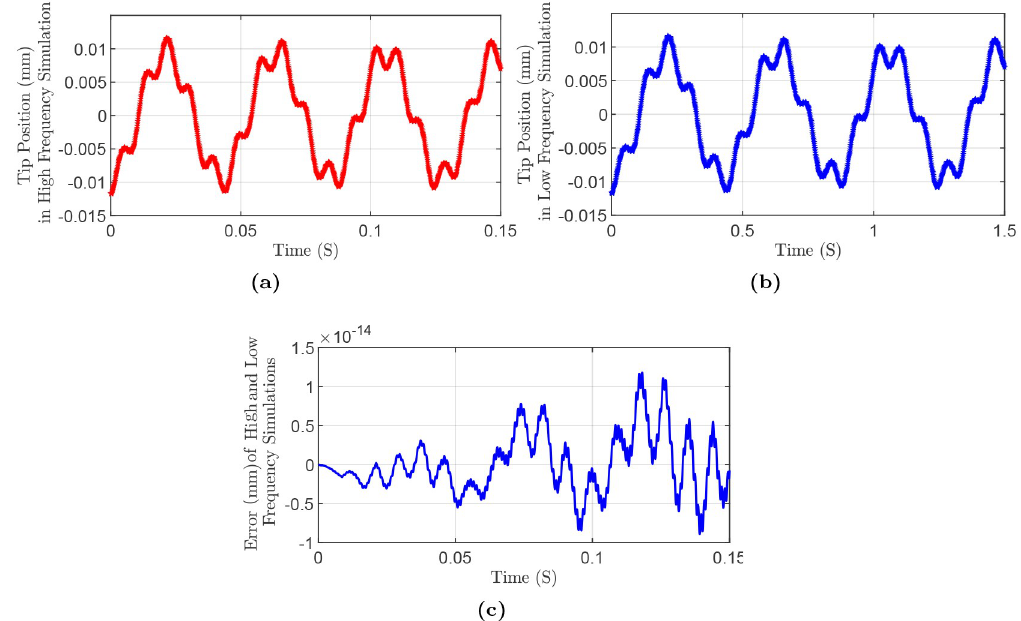
Fig 16. Simulation results for high and low frequency comparison: (a) High frequency. (b) Low frequency. (c) Error of in high and low frequency cases.